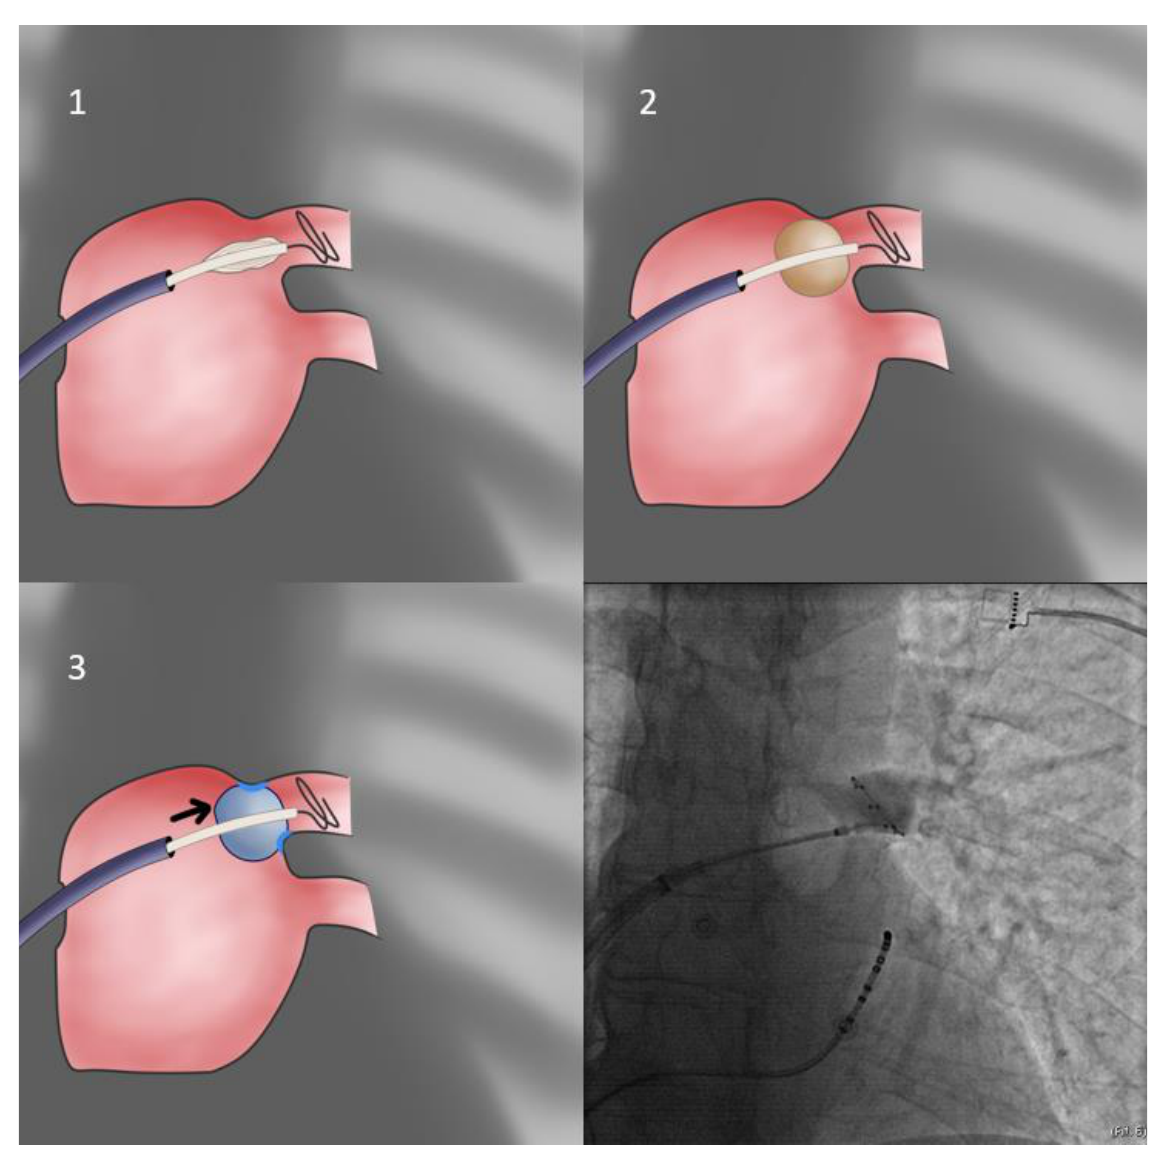
Figure 3. CB-only approach. In cases of unusually oriented veins, it is likely that pressure applied through the stiff catheter sheath will actually offset the balloon relative to the vein, preventing proper occlusion. Thus, the more flexible balloon shaft may be used as a more accommodating alternative. Balloon sheath flexion may or may not be helpful if this approach is chosen, depending on the particular anatomy of each case.